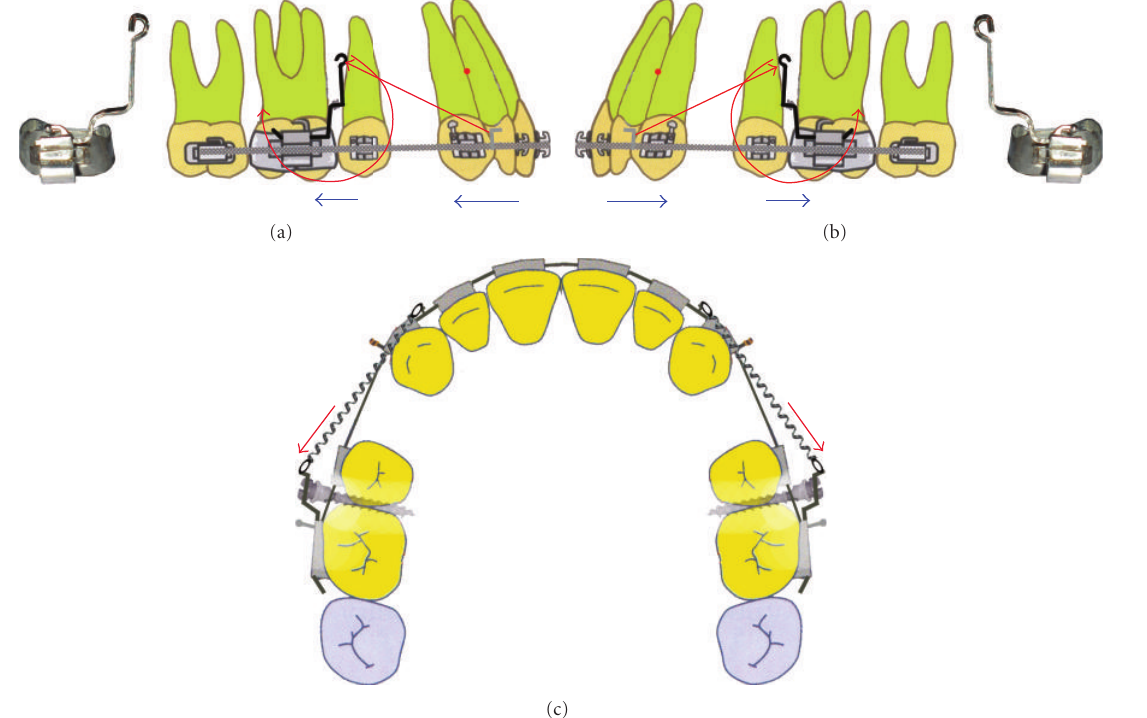
Figure 5: (a, b) Right and left lateral views of biomechanics of space closure with MSPA. (c) Transverse view of miniscrew